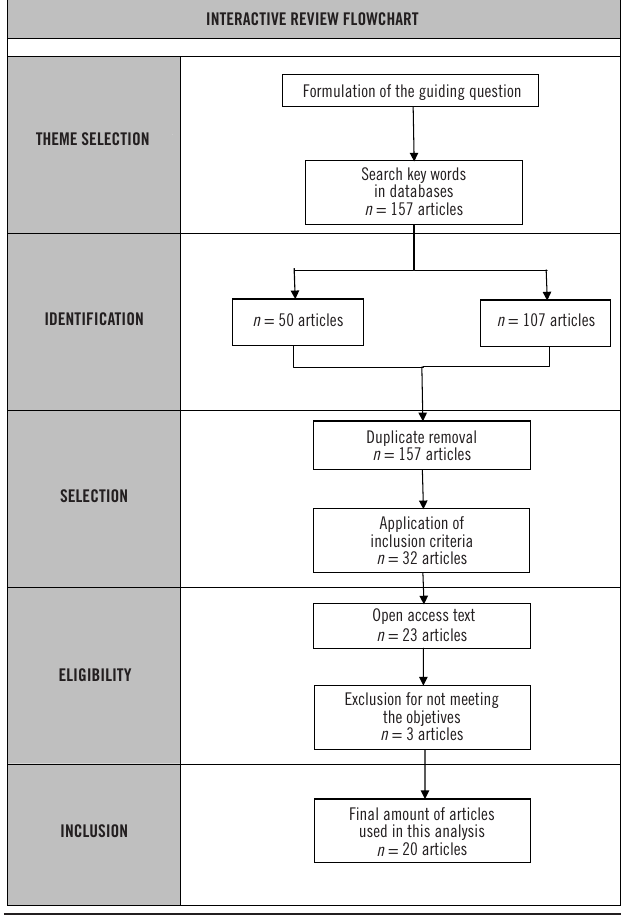
Figura 1 - Fluxograma das etapas de busca e seleção dos artigos analisados FLUXOGRAMA REVISÃO